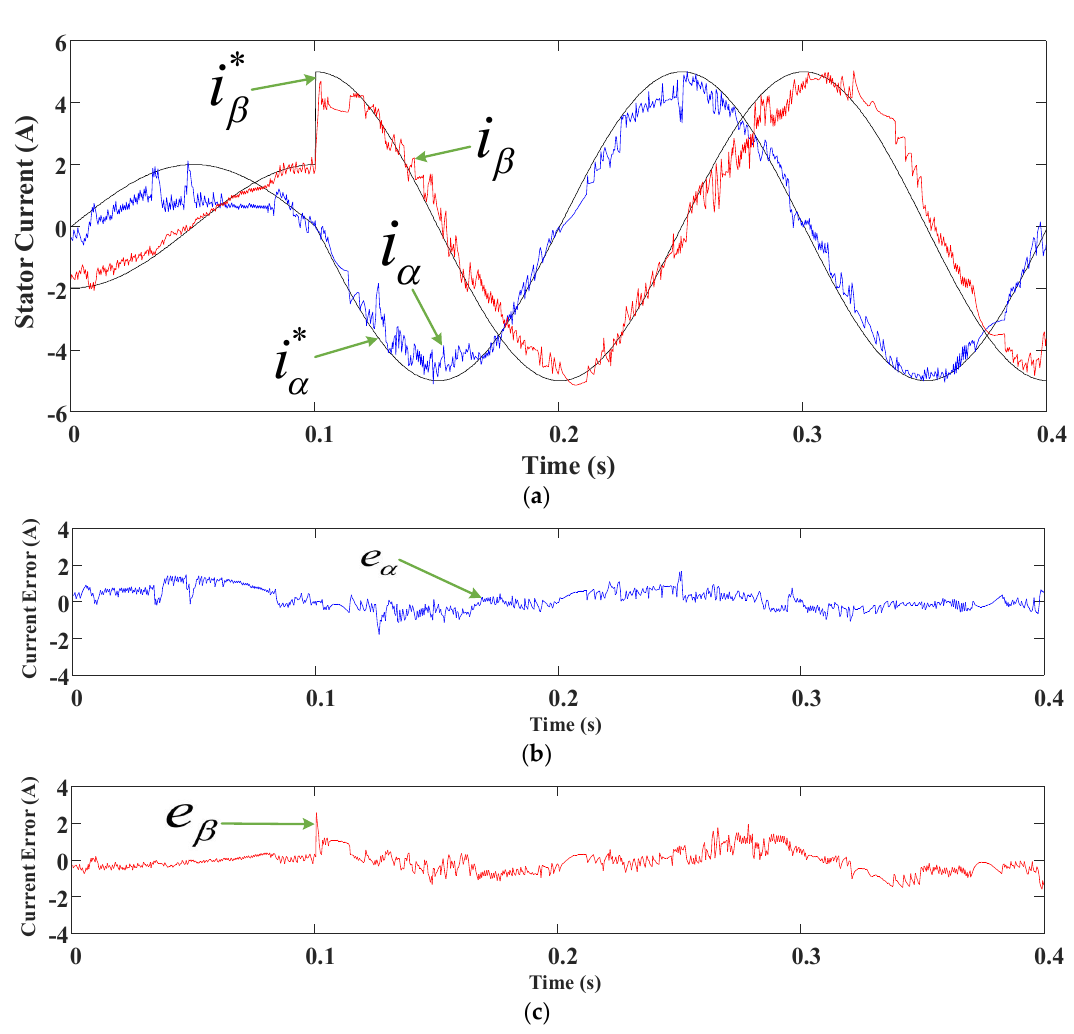
Figure 16. Experimental results of SVV-MPCC following a sinusoidal current command with amplitude jumping from 2 A to 5 A at 0.1 s under frequency 10 Hz (case 3): ( a ) current responses; ( b ) α -axis current error; ( c ) β -axis current error.